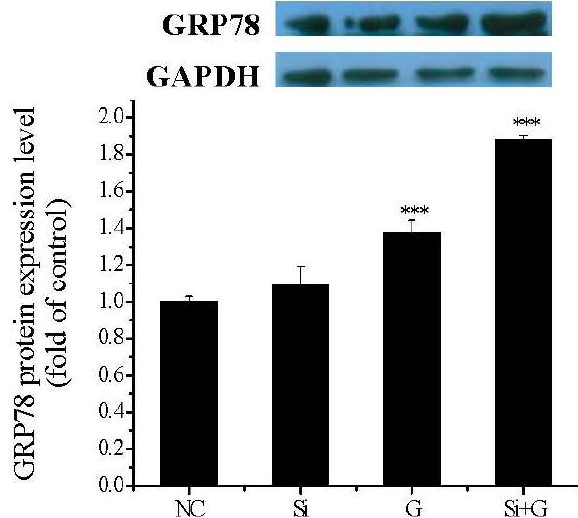
Figure 9. Effect of SelR gene knockdown on D -galactose-induced GRP78 protein expression. Data are the mean ± SD of at least three independent experiments. *** p < 0.001, compared to the negative control group. NC: negative control cells; Si: cells with SelR siRNA transfection for 24 h; G: cells exposed to D -galactose (150 mM) for 36 h; Si+G: cells with SelR siRNA transfection followed by D -galactose exposure.